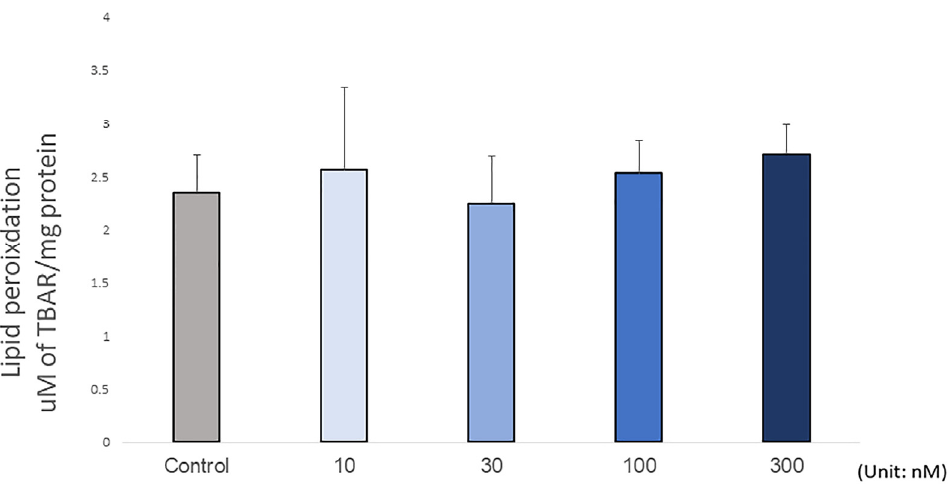
Figure 3. A lipid peroxidation assay was used to determine the toxicity level of the injected concentrations of H 2 O 2 . H 2 O 2 did not alter the embryonic lipid peroxidation 72 h post-injection, indicating the treatment concentrations could be naturally converted to a non-embryonic toxic level by antioxidant enzyme degradation. The treatment groups were compared with the control group using the Dunnett’s test ( p > 0.05; N = 8).